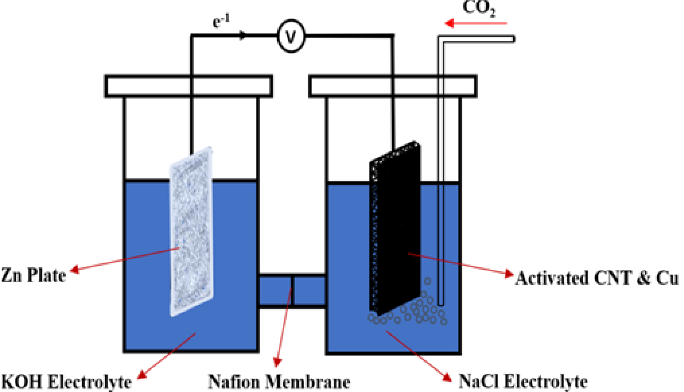
Figure 6. Schematic diagram of the Zn-CO 2 electrochemical cell.